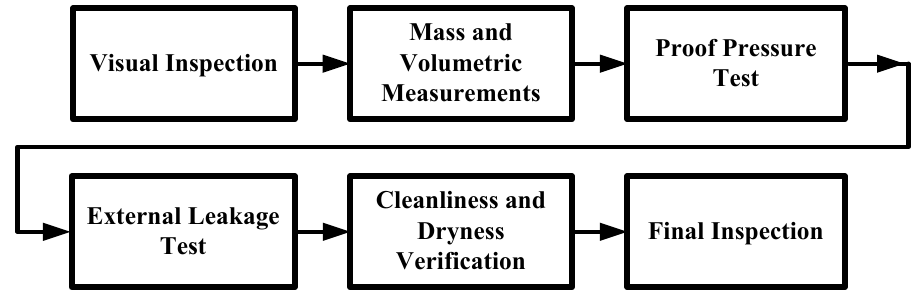
Figure 5. Flow chart showing the sequential acceptance tests performed on each of the five propellant tanks produced for the Adelis-SAMSON